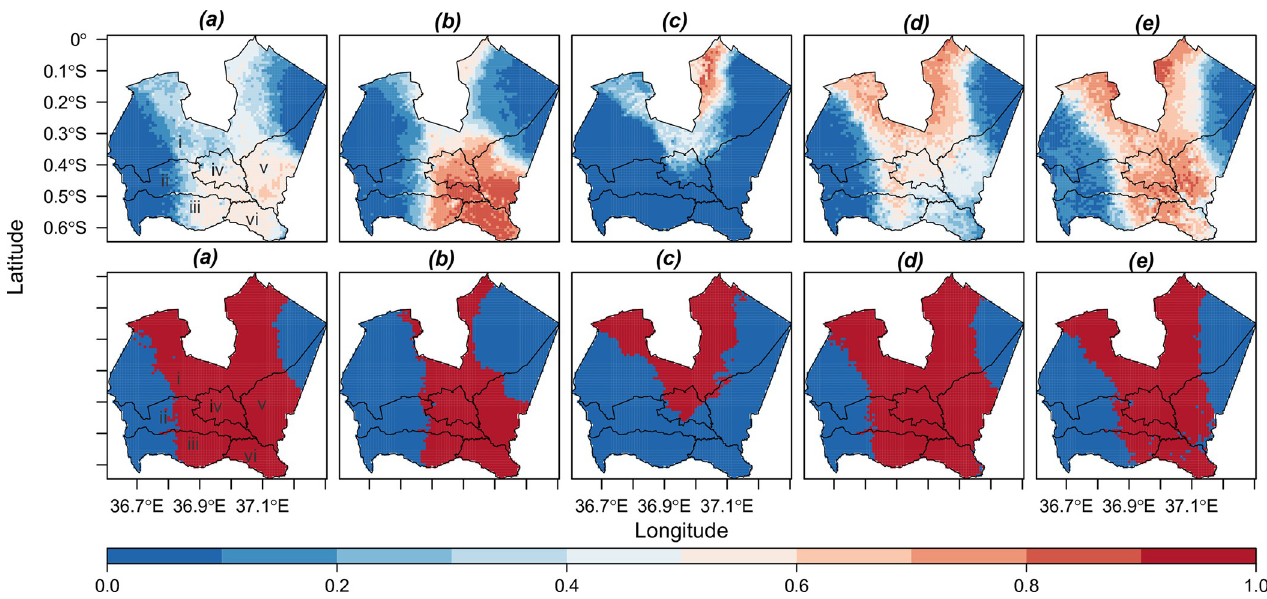
Fig 3. Species current potential ensemble probability suitability maps and respective median binary maps. Suitable areas on the scale are represented by red colour (1) while unsuitable areas are represented by blue colour (0). The black outline denotes the Nyeri sub-county boundaries labelled as follows: i , Kieni; ii , Tetu; iii , Othaya; iv , Nyeri Town; v , Mathira; and vi , Mukurwe-ini Sub-counties and individual species as follows : (a) , C . decapetala (Roth) Alston; (b) , L . camara; (c) , O . stricta (Haw . ) Haw . ; (d) , S . didymobotrya; (e) , S . campylacanthum . Data Source: (Administrative Boundary Layer: GADM database (www.gadm. org) under CC BY 4.0 license